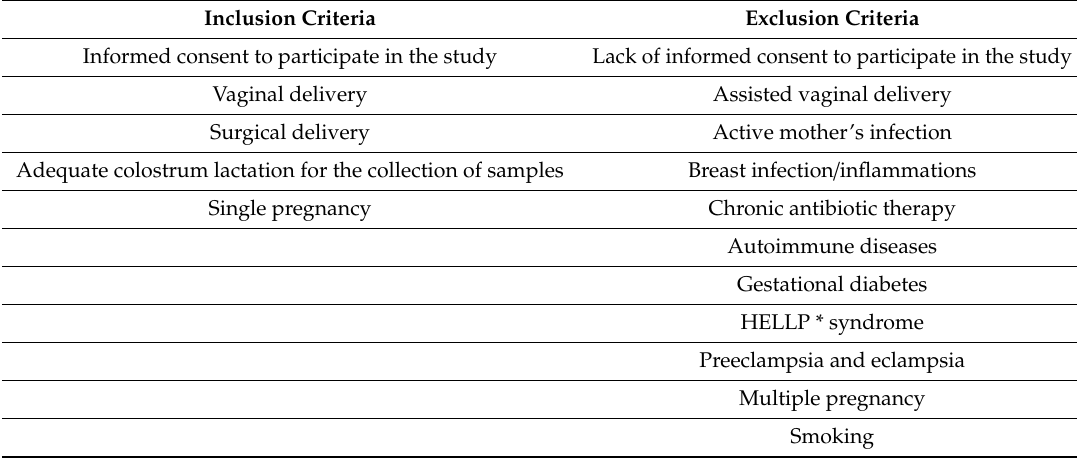
Table 1. Inclusion and exclusion